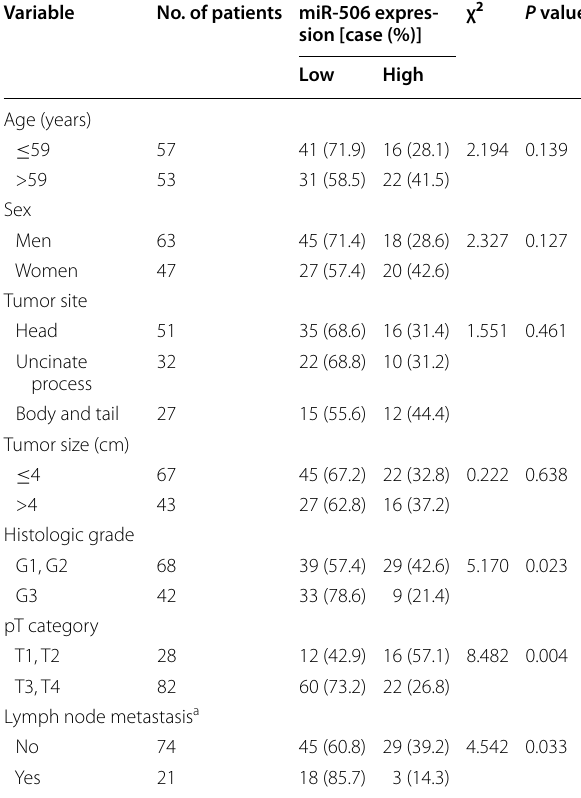
a No information about lymph node metastasis in 15 patients